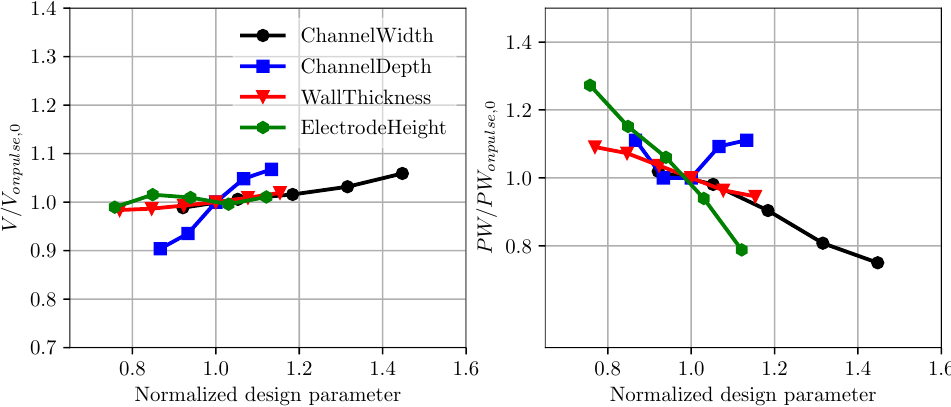
Figure 22. Onpulse velocity and pulse width with changes in channel dimensions. The quantities are normalized with the baseline